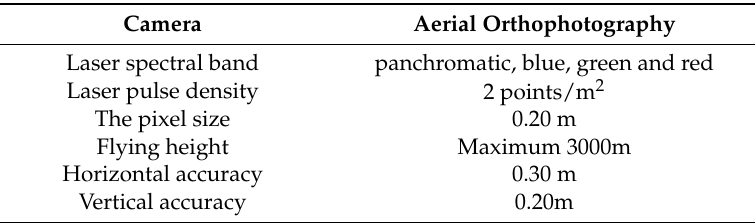
Table 2. LiDAR sensor specifications.